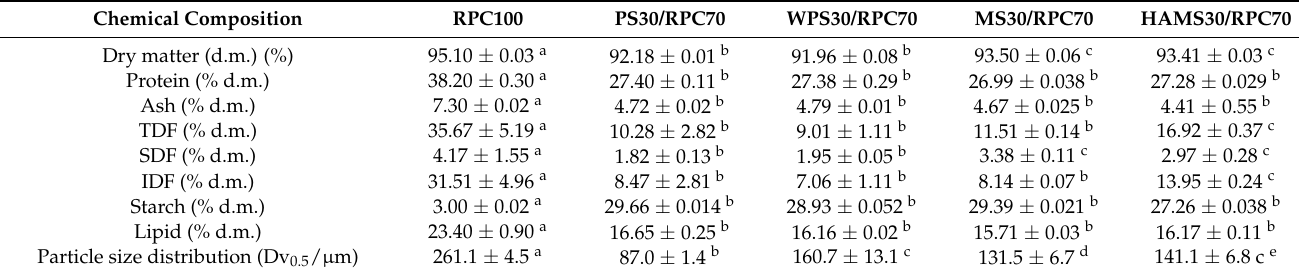
Table 2. Chemical composition of rapeseed press cake (RPC100) and blends of 30 g/100 g potato starch (PS), waxy potato starch (WPS), maize starch (MS) and high-amylose maize starch (HAMS) in combination with 70 g/100 g RPC. Chemical Composition RPC100 PS30/RPC70 WPS30/RPC70 MS30/RPC70 HAMS30/RPC70 Dry matter (d.m.) (%) 95.10 ± 0.03 a 93.41 ± 0.03 c Protein (% d.m.) 38.20 ± 0.30 a 27.28 ± 0.029 b Ash (% d.m.) TDF (% d.m.) SDF (% d.m.) 2.97 ± 0.28 c IDF (% d.m.) 13.95 ± 0.24 c Starch (% d.m.) Lipid (% d.m.) Particle size distribution (Dv 0.5 / µ m) Mean values with different superscript letters within one row indicate significant differences ( p < 0.05) based on a one-way analysis of variance (ANOVA). Where appropriate, the mean values were compared using Tukey’s honest significance